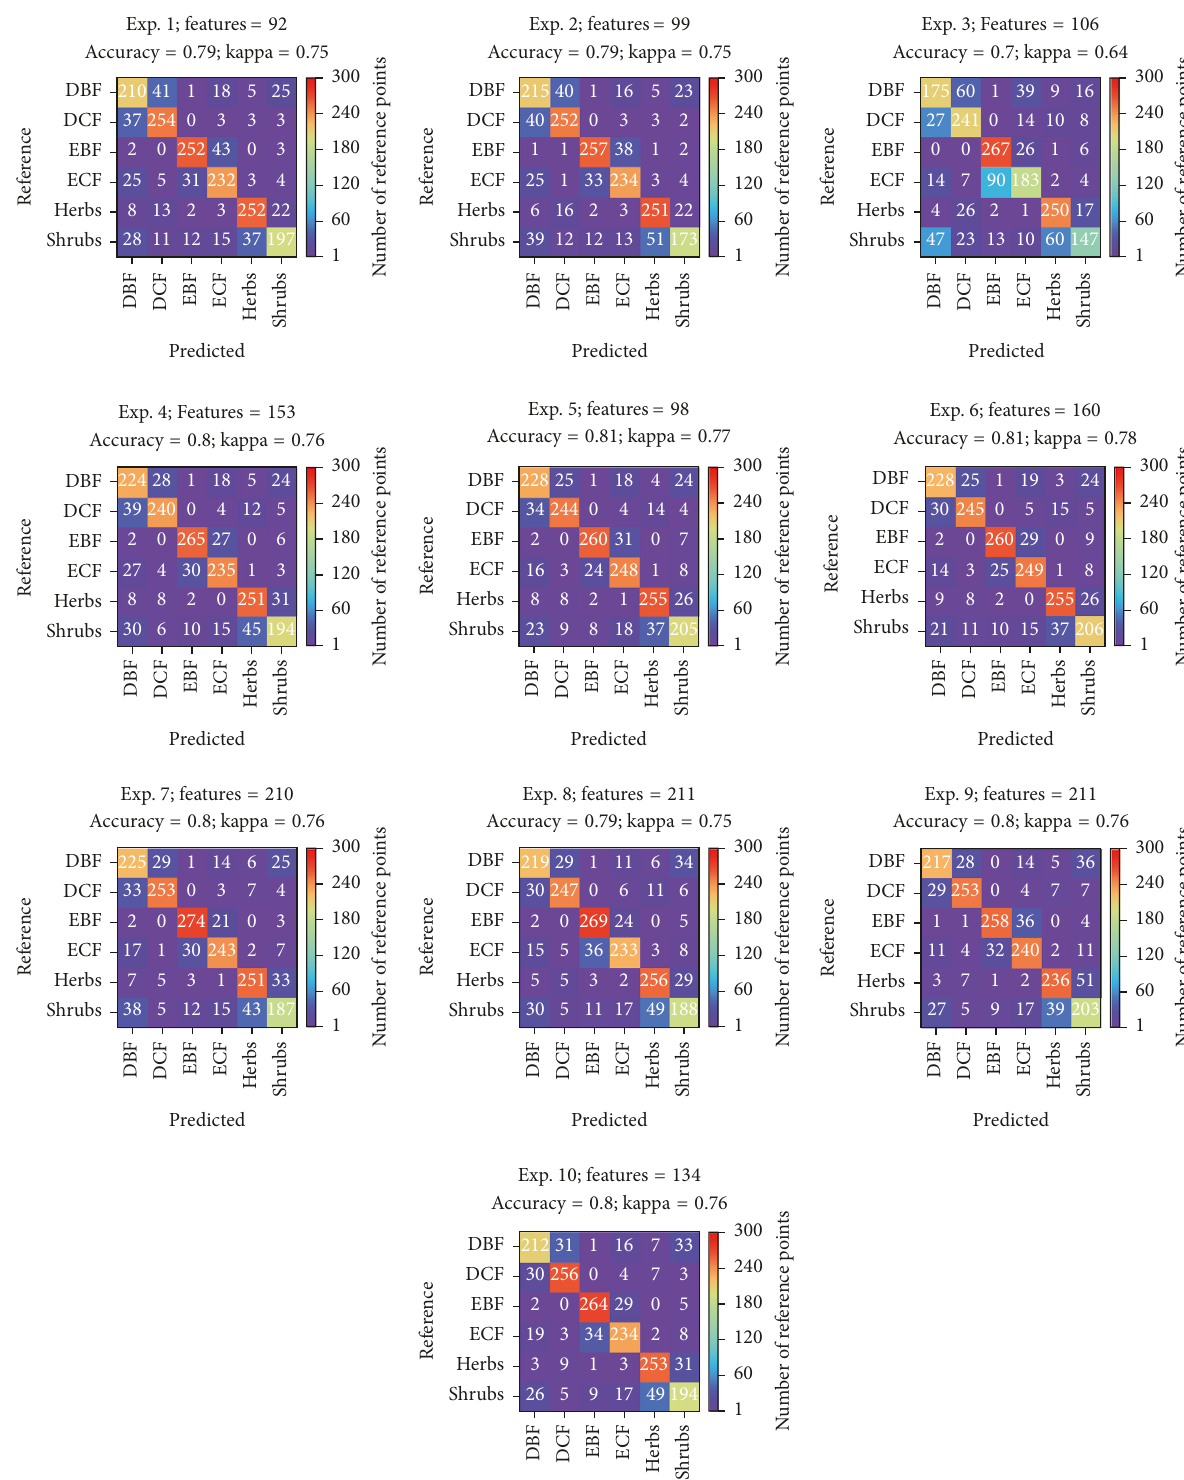
Figure 1: Confusion matrices for each experiment computed in the case of optimum number of